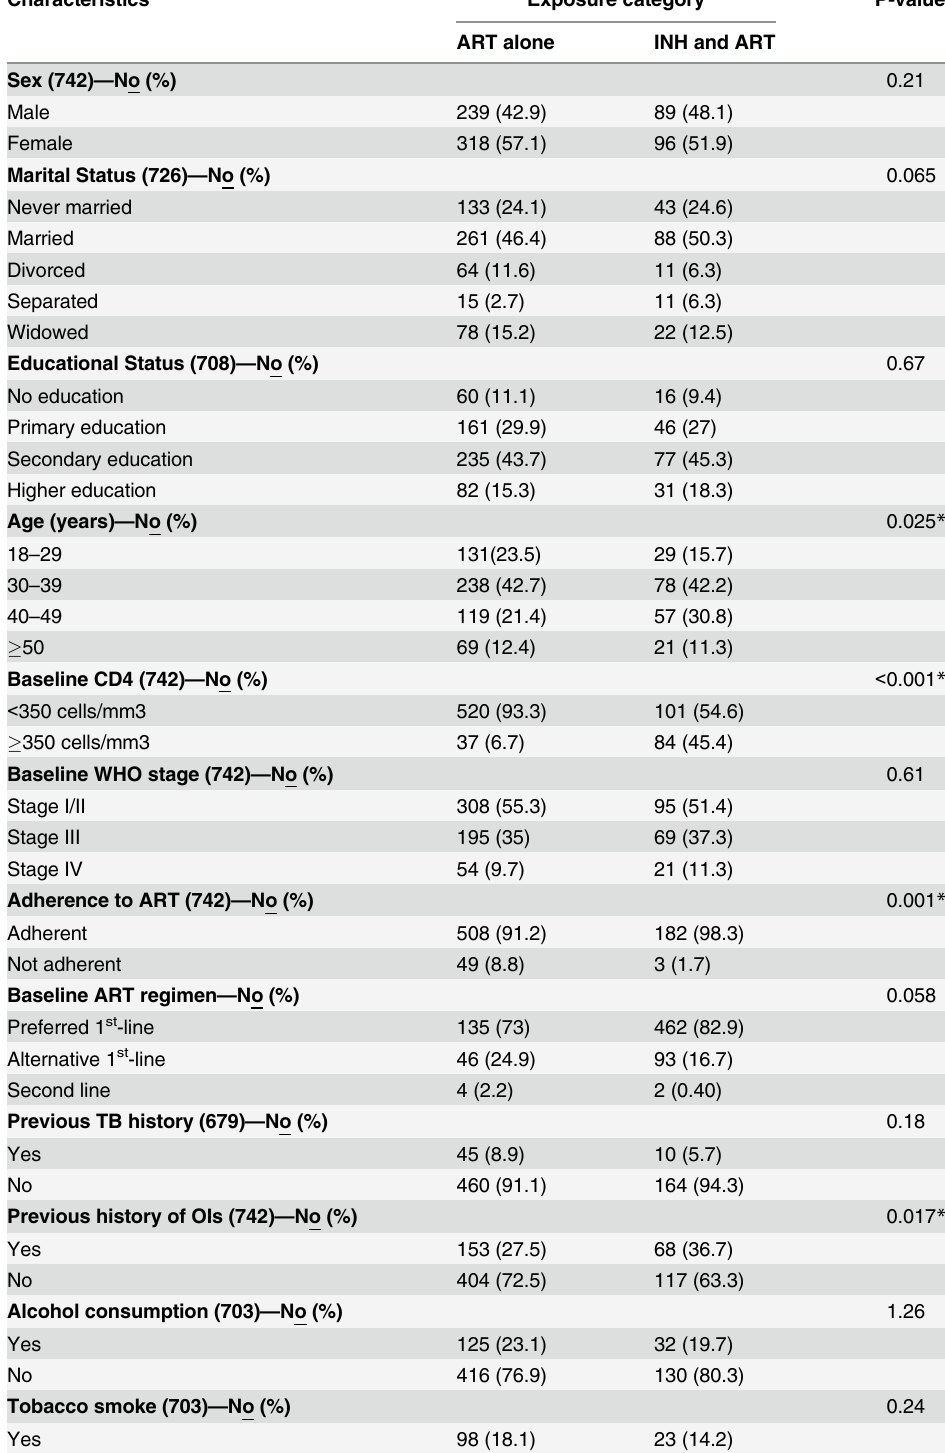
Table 1. Baseline demographic and clinical characteristics of patients stratified by exposure catego- ries, Addis